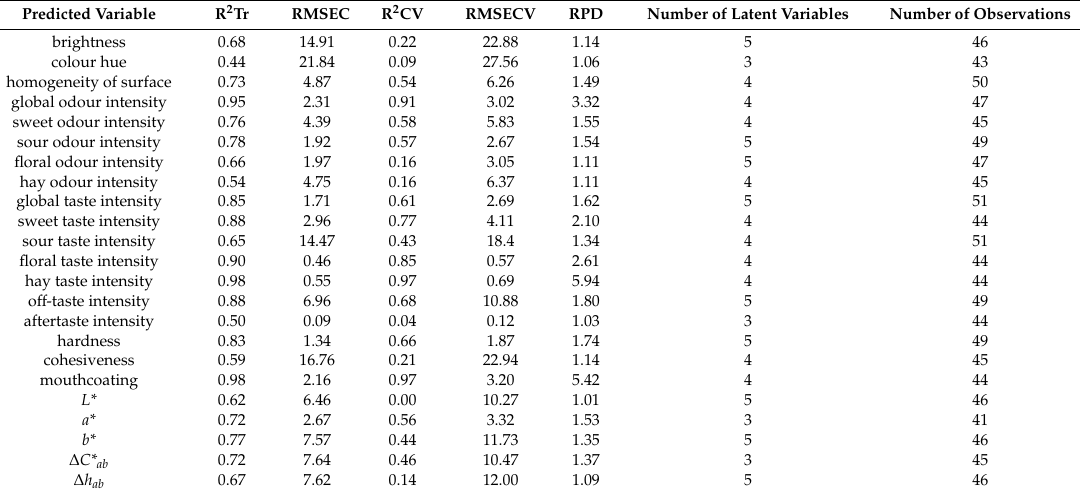
Table 8. Results of the regression models built on the properties of sensory profile analyses and colour parameters of pollen samples based on data of the electronic